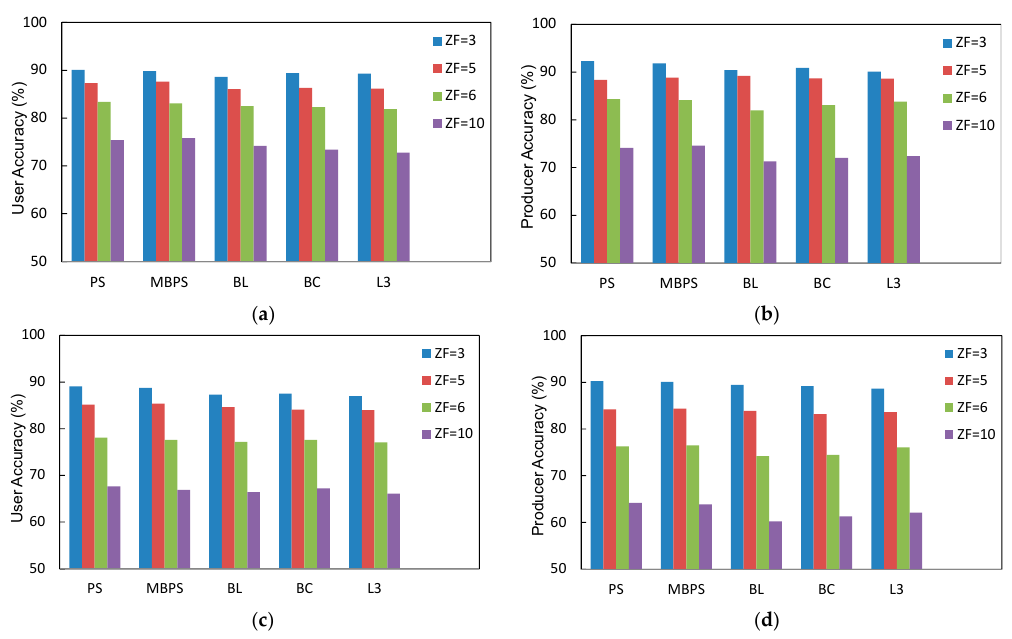
Figure 22. User and producer accuracies of SRM algorithms using real water fractions of: ( a , b ) the SPU algorthom, and ( c , d ) the OBA-NDWI algorithm across a range of ZF for Sarca River; (PS: pixel swapping, MBPS: modified binary PS, BL: bilinear, BC: bicubic, L3: lanczos3).